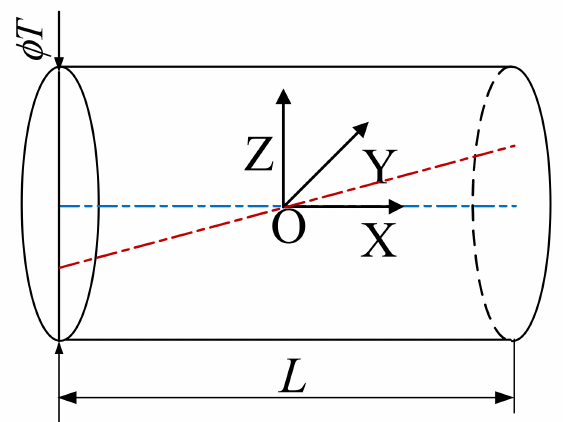
Figure 3. Variation of the spin volume of the cylindrical axis